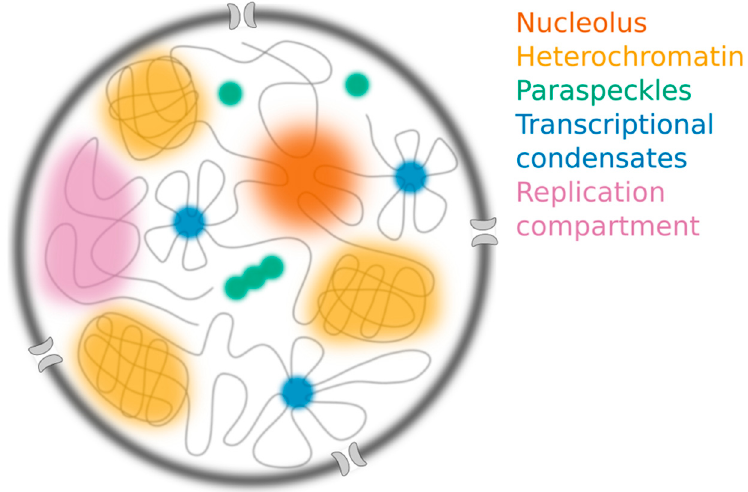
Figure 2. The nucleus contains many different membraneless structures, including the nucleolus (orange), constitutive heterochromatin compartments (yellow), paraspeckles (green) and transcriptional condensates (blue), which have all been proposed to assemble through liquid-liquid phase separation (LLPS). Replication compartments (purple) form following infection by herpes simplex virus.